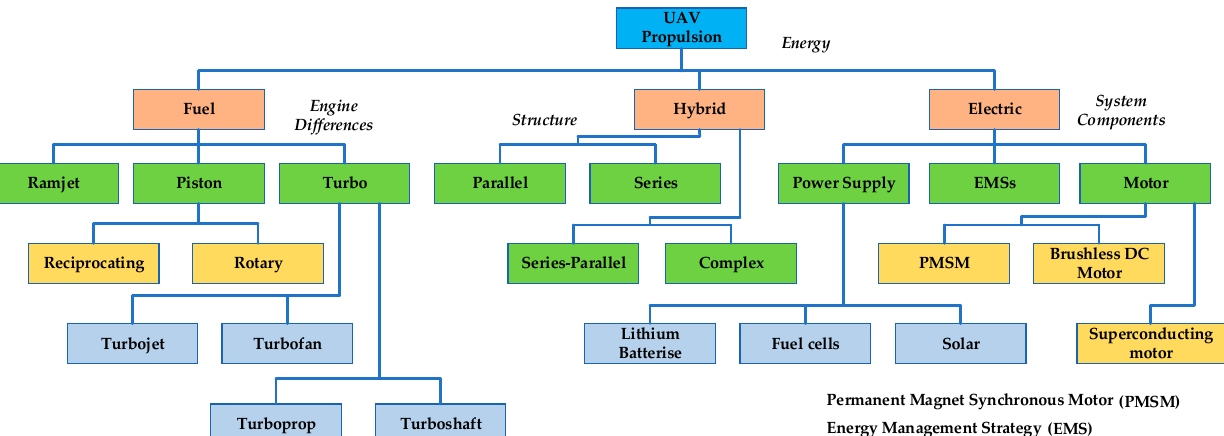
Figure 3. UAV propulsion classification based on energy types.